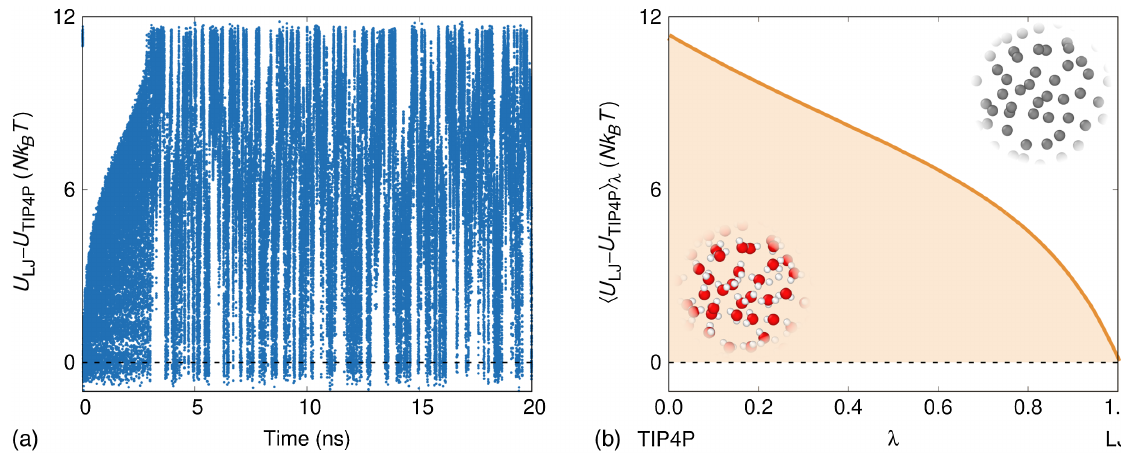
FIG. 4. Calculation of the free energy of liquid TIP4P water using a single-simulation thermodynamic integration. (a) Evolution of the collective variable Δ U as a function of simulation time. (b) Integrand for the thermodynamic integration obtained through